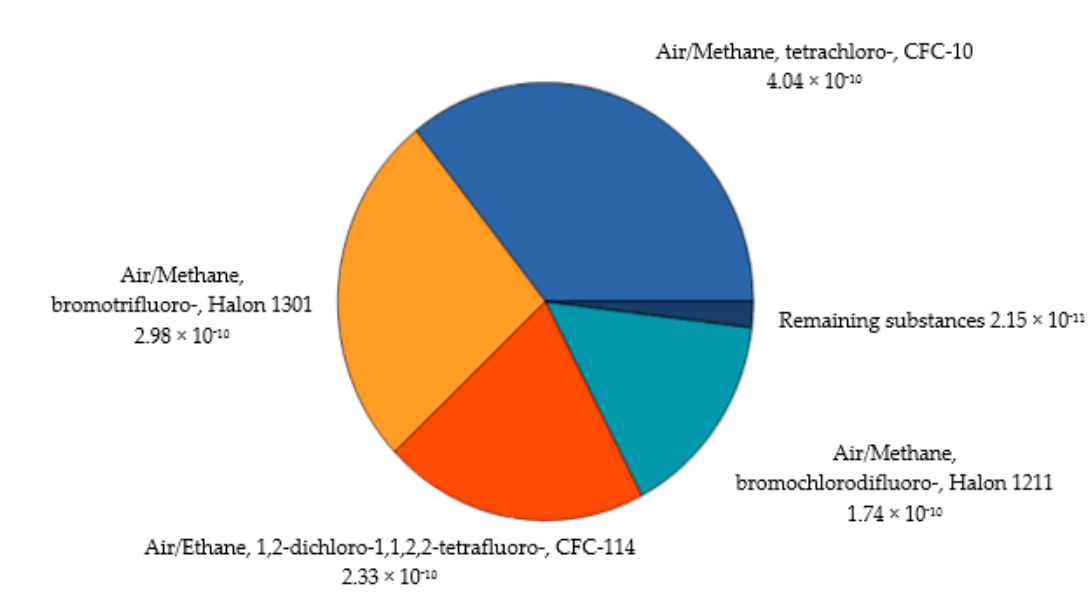
Figure 9. Ozone depletion damage assessment of 1 kg of SPF-reinforced sago starch composite takeout food container (damage assessment/excluding long-term emissions/cut off 1%).